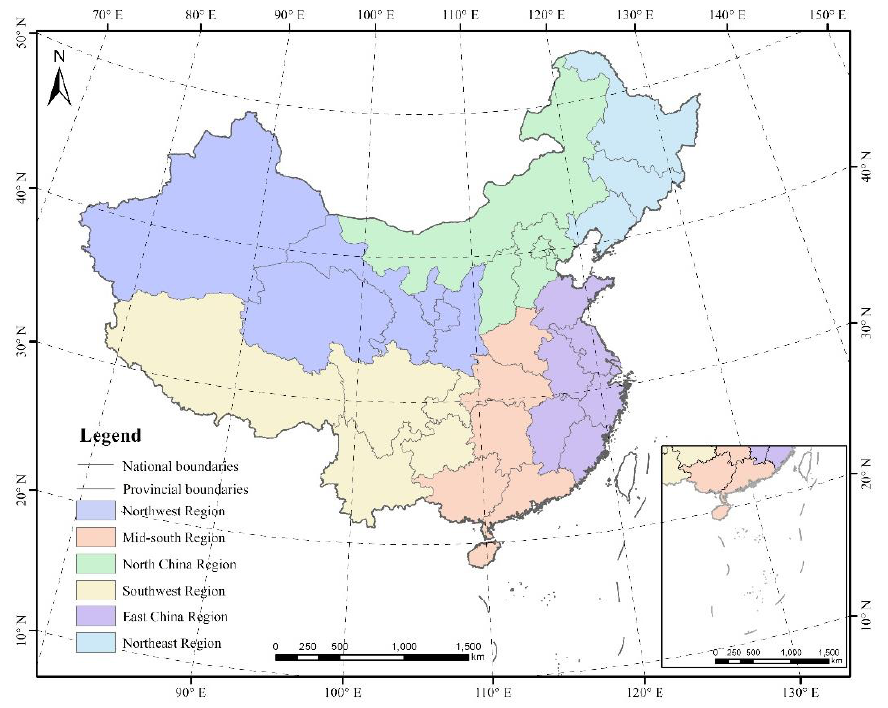
Figure 1. Six geographical regions in China. 2